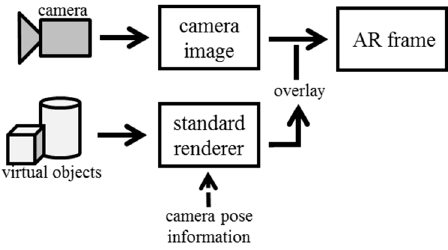
Figure 20. Augmented reality (AR) instruments’ connection.